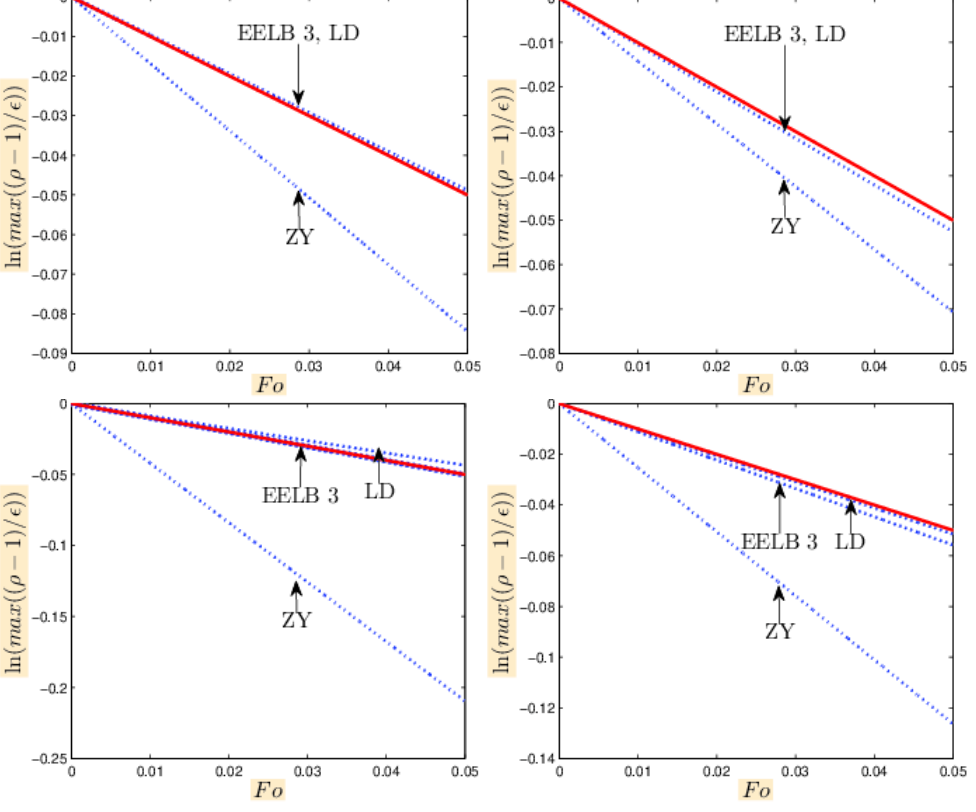
Figure 5. Acoustic waves, upper slides: Ma = 0.2, lower slides: Ma = 0.4; left slides: k x = 2 π /8, k y = 0 and the right slides: k x = 2 π /16, k y = 2 π /12. LD is the low-dissipative en- tropic method described in Proposition 1; EELB 3 is the third-order EELB method; ZY is the method of Zhao and Yong. The Navier–Stokes solutions are denoted as: ( − )